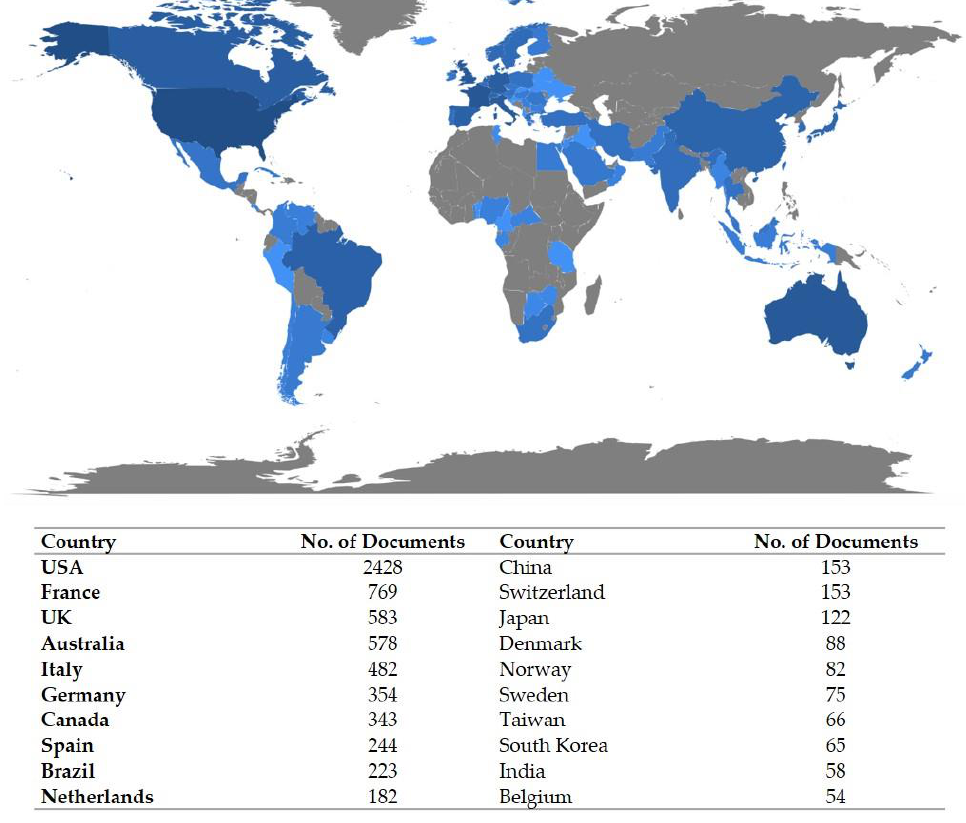
Figure 1. Country-specific production. The color intensity is proportional to the number of docu- ments. Higher blue intensity refers to greater number of documents (dark blue = high productivity; grey = no documents).